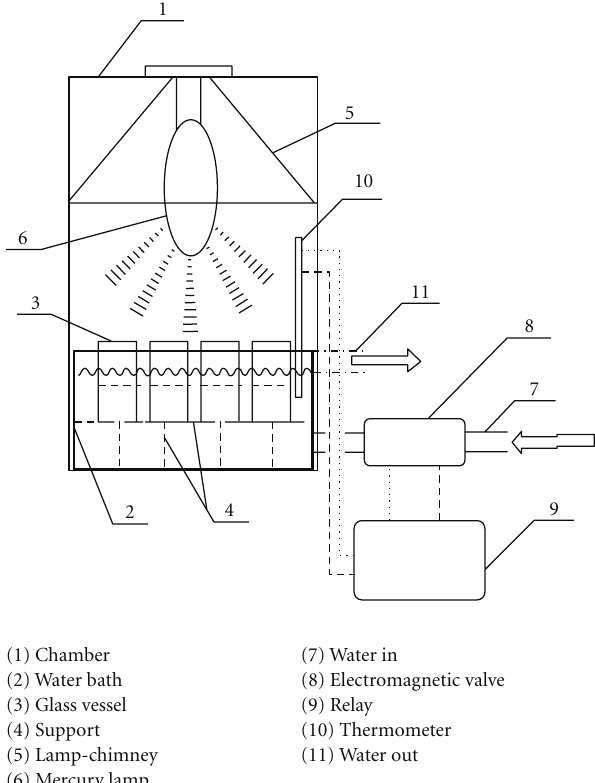
Figure 1: The schematic diagram of photoreaction system. FZ-A radiometer (BNU Light and Electronic Instrumental Co., China), respectively. The diagram of the photoreaction system was presented in Figure 1.